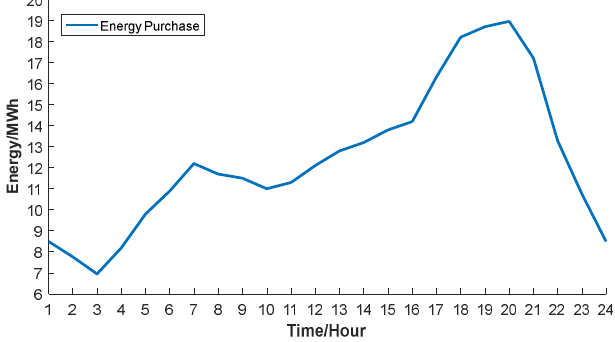
Figure 10. The amount of electricity purchased over 24 h in the wholesale Figure 10 . The amount of electricity purchased over 24 h in the wholesale market.